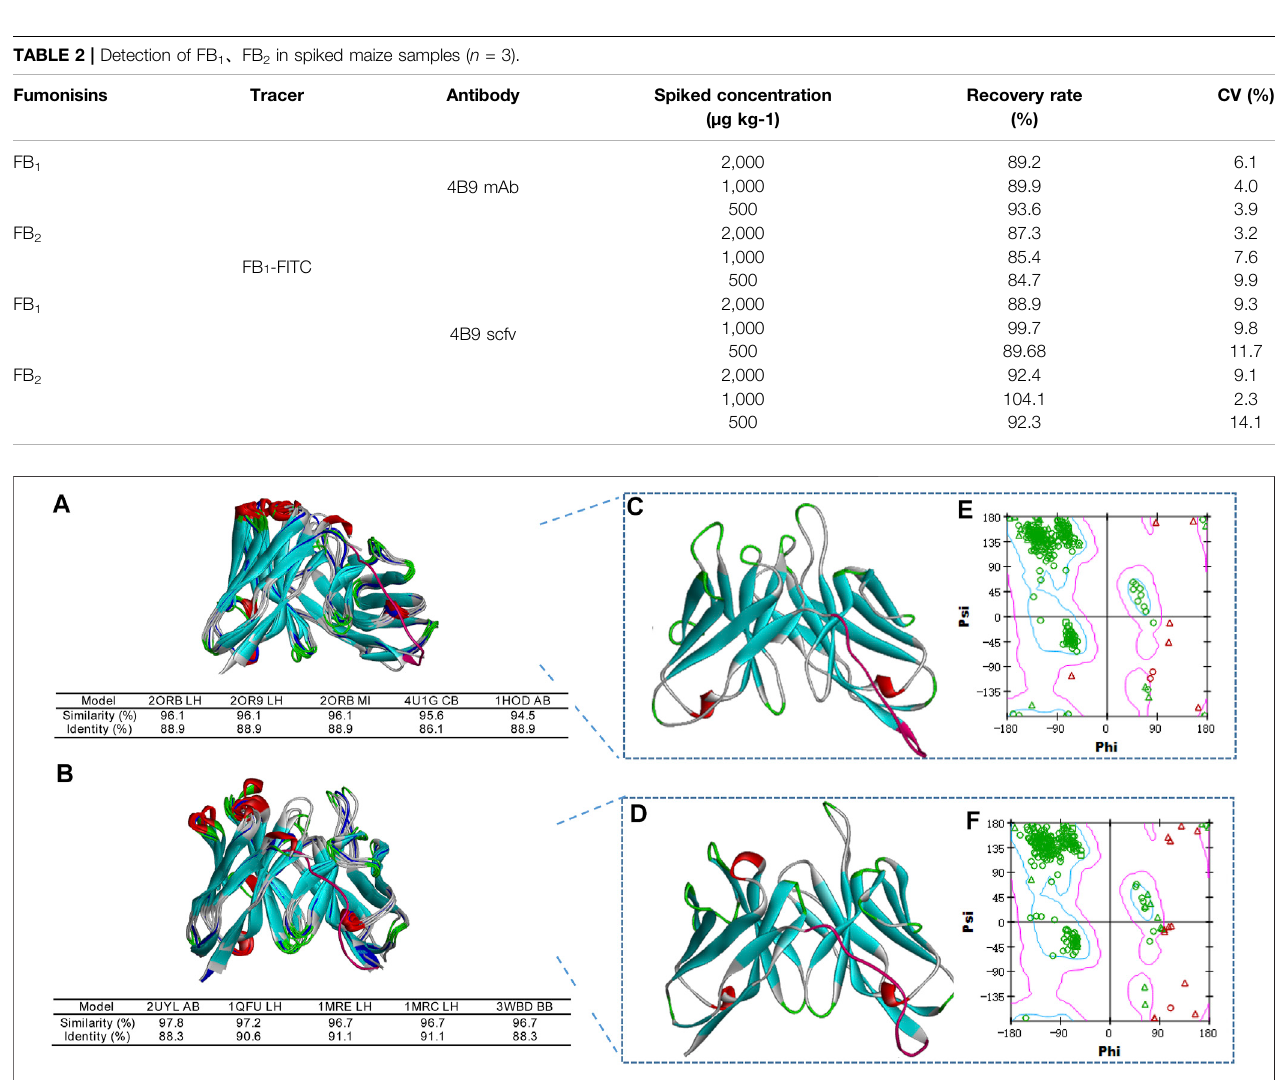
FIGURE4| Homologymodellingof4F5scFvand4B9scFv. (A,B) :Themultiplealignmentofthe fi vetemplateswith4F5scFvand4B9scFv. (C,D) :The3Dmodels of 4F5 scFv and 4B9 scFv. (E,F) : The Ramachandran plots of 4F5 scFv and 4B9 scFv.